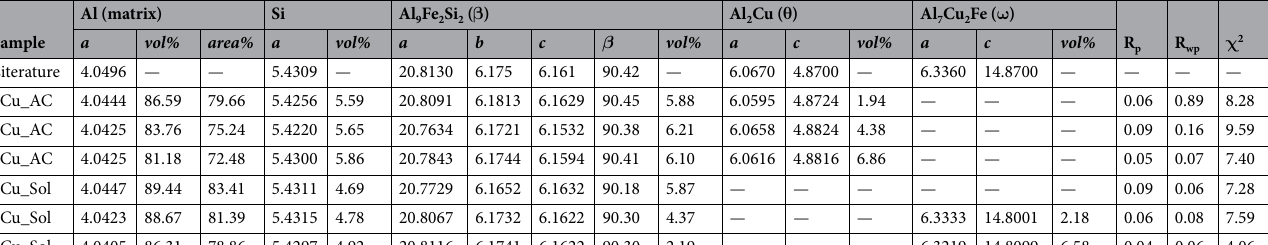
Table 1. Lattice parameters ( × 10 nm) and phase fraction (vol%) of different phases of as-cast (AC) and solutionized (Sol) sample from XRD analysis with R p , Rw p and χ 2 parameters indicating goodness of fitting. Solutionized condition implies soaking at 793 K for 684 ks and then water quenched. Area% indicated under Al (matrix) column is the result from the image analysis.